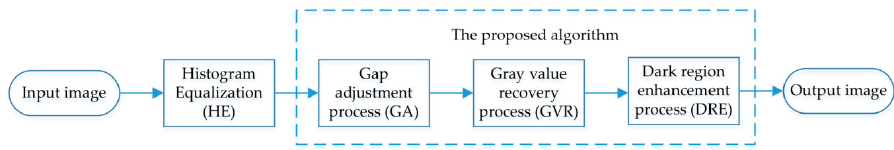
Figure 2. The block diagram of CegaHE.